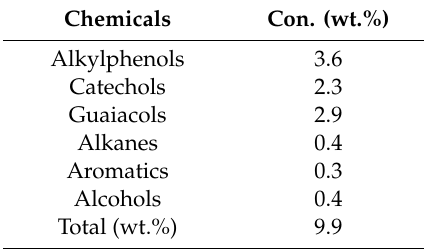
Table 2. Monomeric components in PL by GC × GC